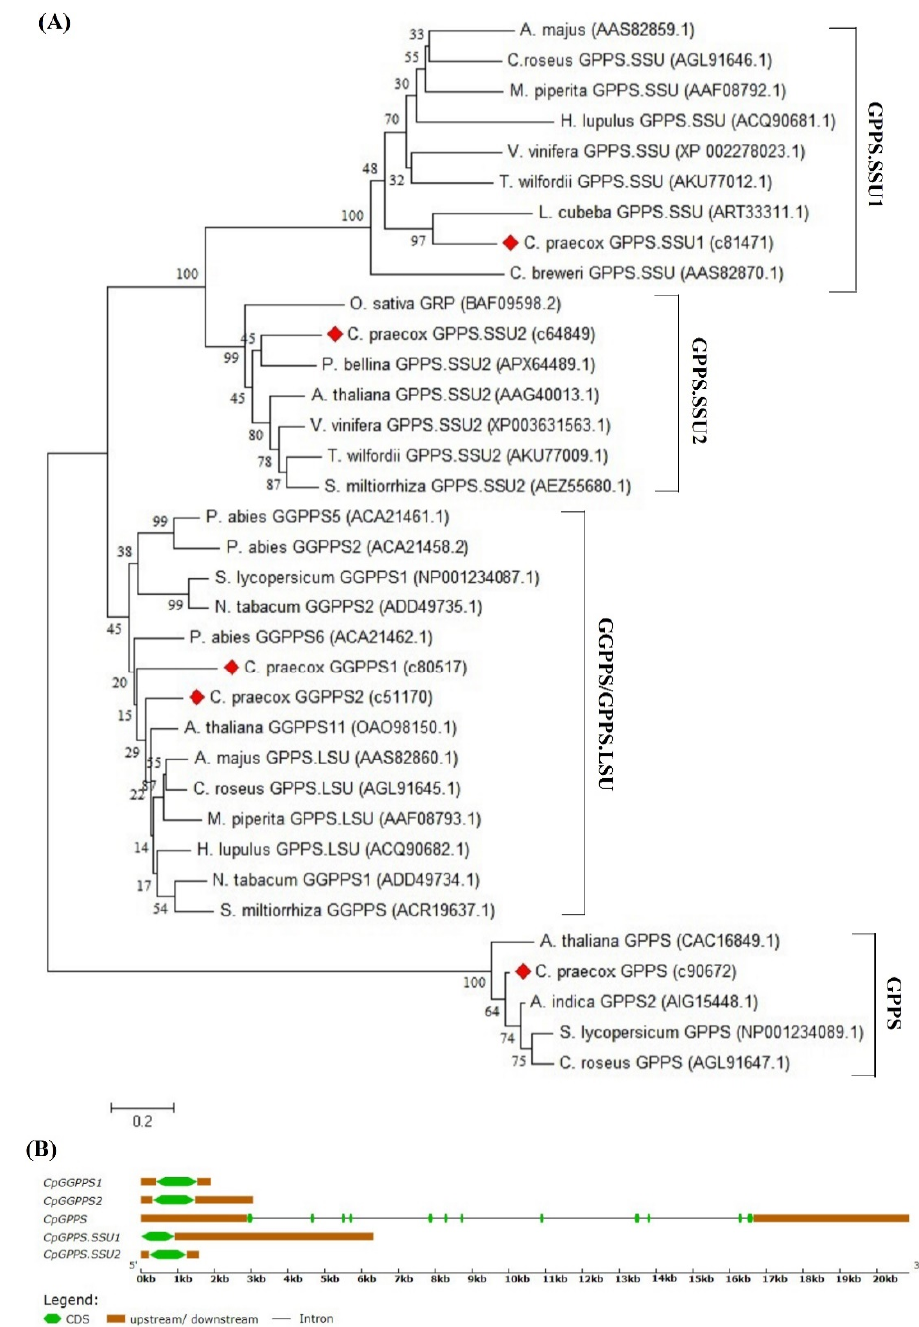
Figure 1. Phylogenetic and gene structure analysis of the wintersweet geranyl diphosphate synthase (GPPS)/geranylgeranyl diphosphate synthase (GGPPS). ( A ) The phylogenetic tree was generated by the neighbor-joining method using the MEGA 7.0, after alignment of deduced amino acid sequences by ClustalW. Numbers in the nodes are the bootstrap support values from 1000 replicates. The accession numbers are given in parenthesis. ( B ) Schematic genomic structure of Cp GPPS/GGPPS genes. The green box represents the exon and the black lines between them denote intron. The dark orange box represents the untranslated region.